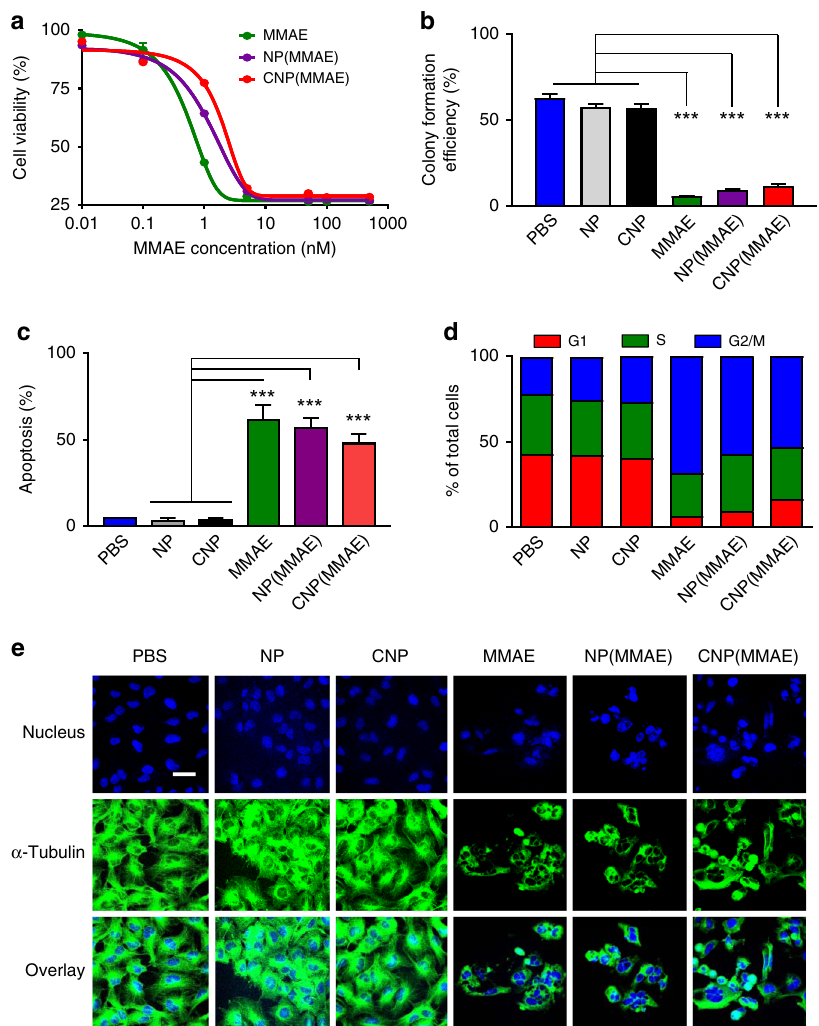
Fig. 4 In vitro activity of MMAE-conjugated nanoparticles. a Relative cellular viability of OVCAR8 ovarian cancer cells after 72 h of incubation with free MMAE, uncoated and MMAE-conjugated nanoparticles (NP(MMAE)), or coated and MMAE-conjugated nanoparticles (CNP(MMAE)). b Relative ef fi ciency of colony formation for OVCAR8 cells at 7 days after cellular exposure to free MMAE, NP(MMAE), or CNP(MMAE) and in comparison to various control treatments (PBS, empty nanoparticles (NP), and empty coated nanoparticles (CNP)). Flow cytometry measurements were performed to determine c the percentages of cells undergoing apoptosis and d the cell-cycle distribution of OVCAR8 cells at 48 h after continuous exposure to different MMAE-containing formulations or various controls. e α -Tubulin immuno-detection by confocal microscopy, con fi rming the preserved ability of MMAE- conjugated nanoparticles (NP(MMAE) and CNP(MMAE)) to enable destabilization of tubulin within the cytoskeleton of OVCAR8 cells and as compared to the cellular responses to free MMAE. Scale bar = 40 μ m (*** p -value < 0.001, unpaired t